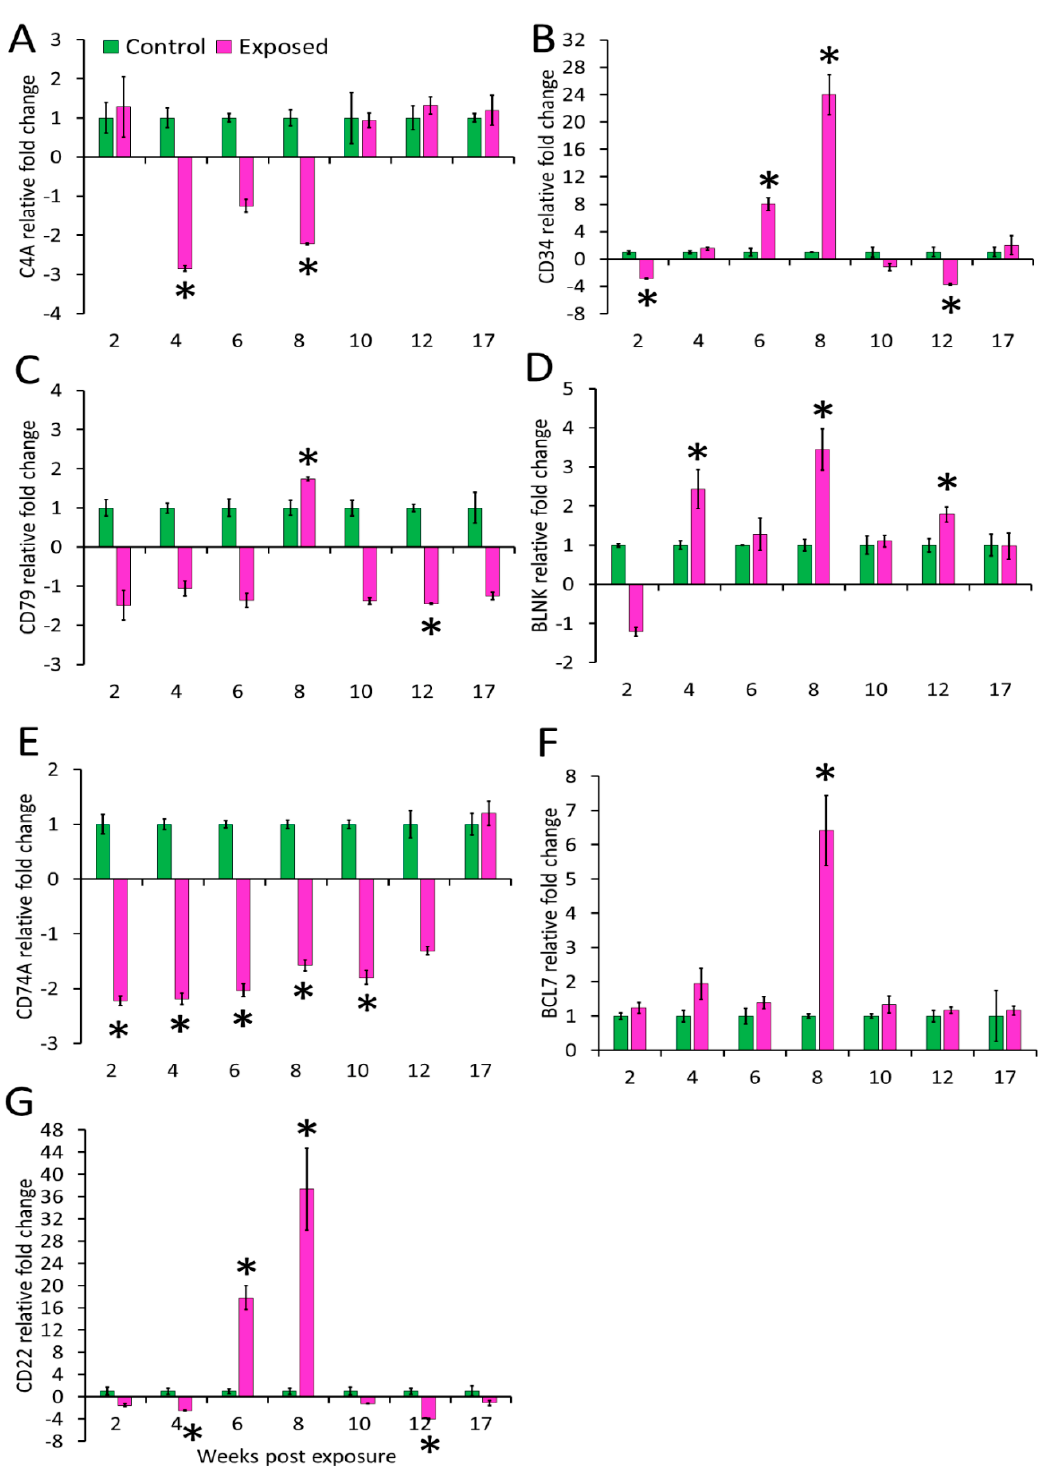
Figure 5. Relative expression of immune genes in spleen. ( A ) C4A; ( B ) CD34; ( C ) CD79A; ( D ) BLNK; ( E ) CD74; ( F ) BCL7, and ( G ) CD22. The relative fold change was first normalised to EF-1 and β -actin, and then represented as a fold change relative to control fish gene expression levels. Asterisks (*) denote the significant difference in relative fold change expression. Each bar shows the mean ± SEM ( n = 6).